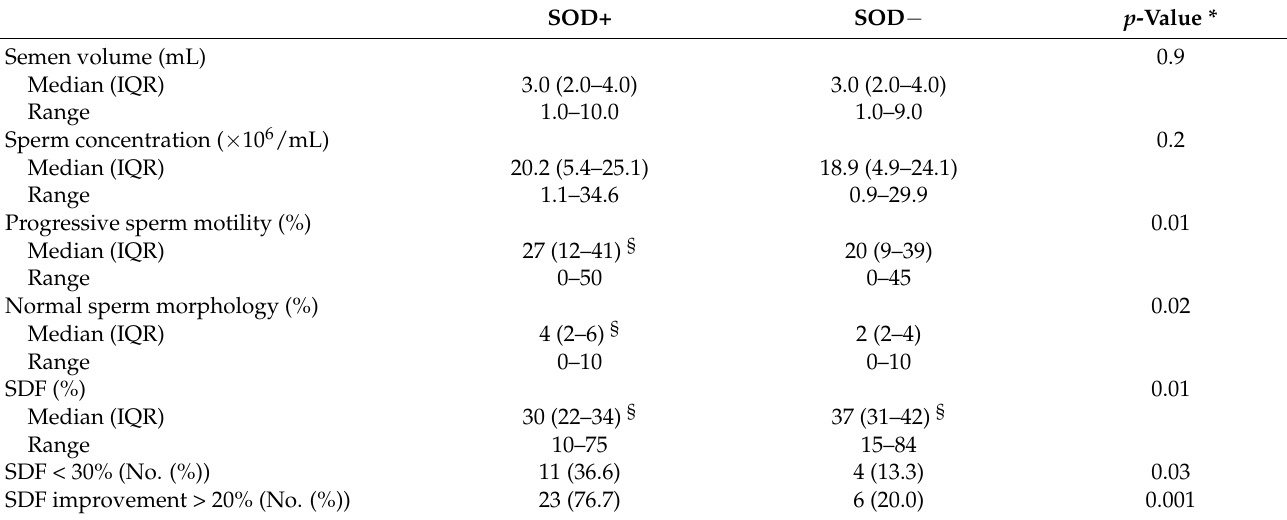
Table 2. Semen characteristics at 3-month follow-up assessment.